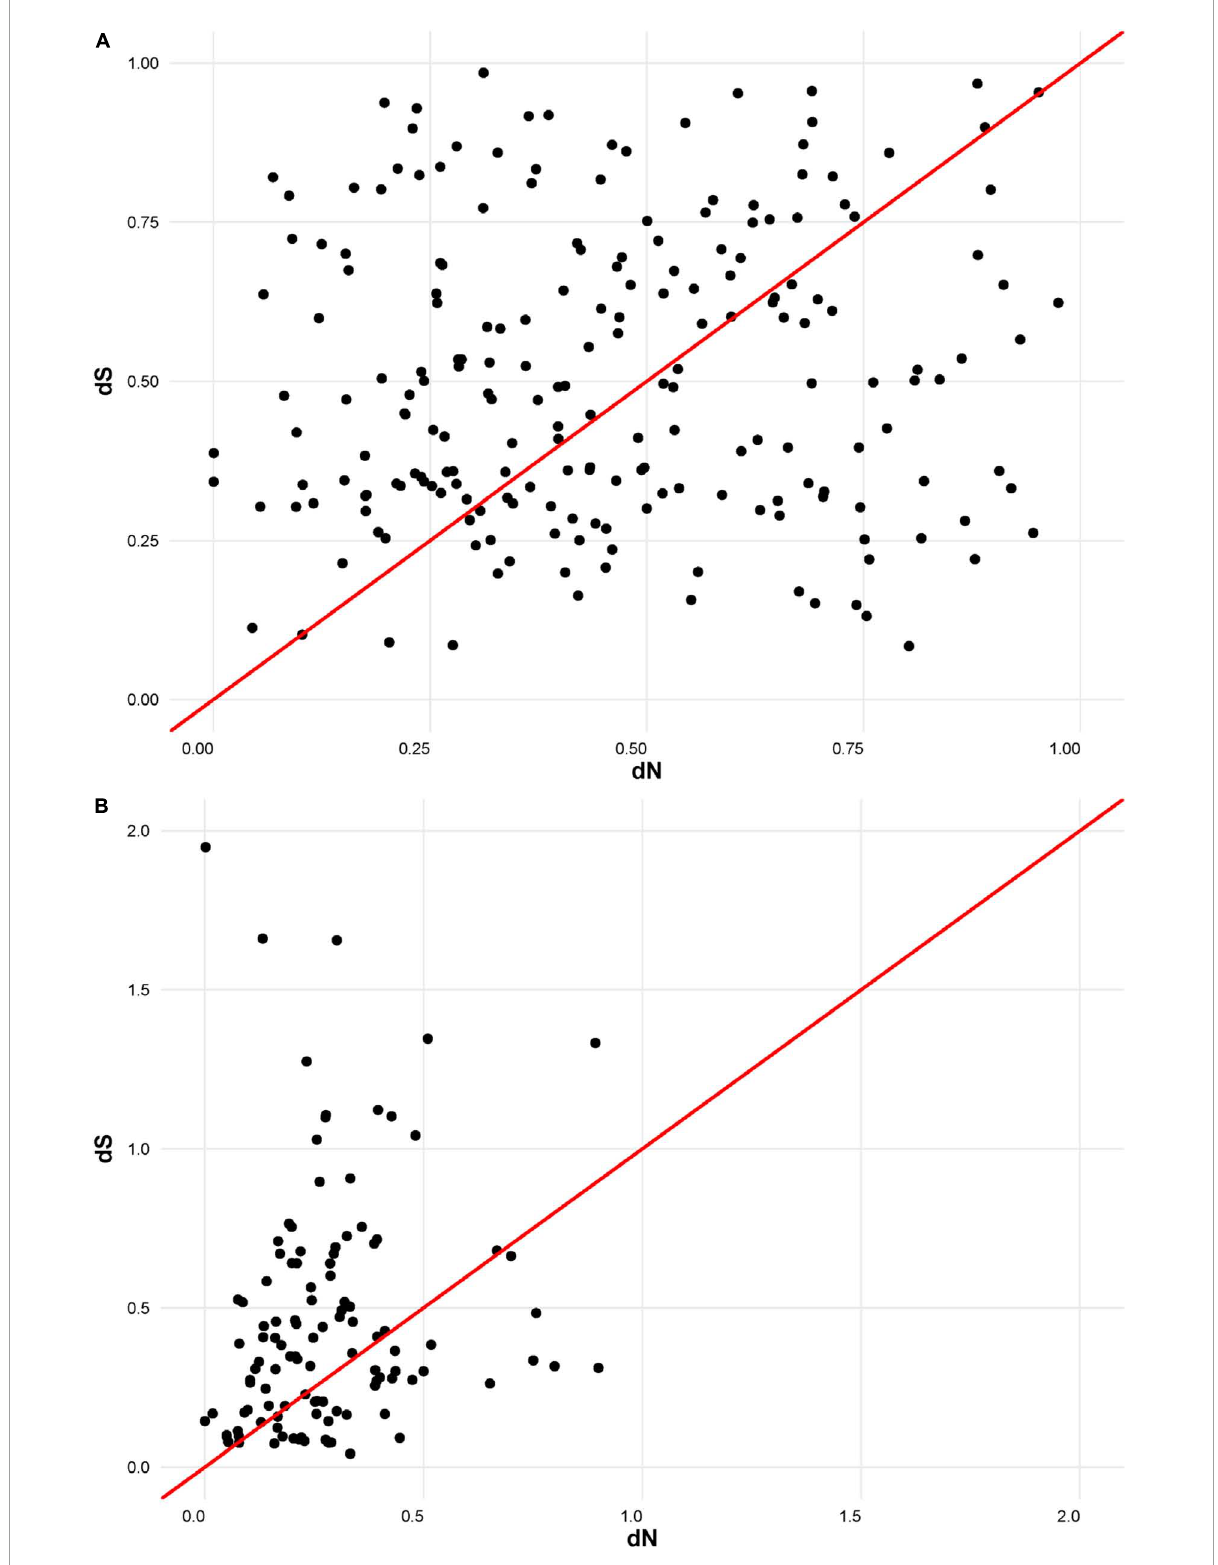
FIGURE2 (A) dN/dS ratios for mature part of NCR peptides. (B) dN/dS ratios for signal part of NCR